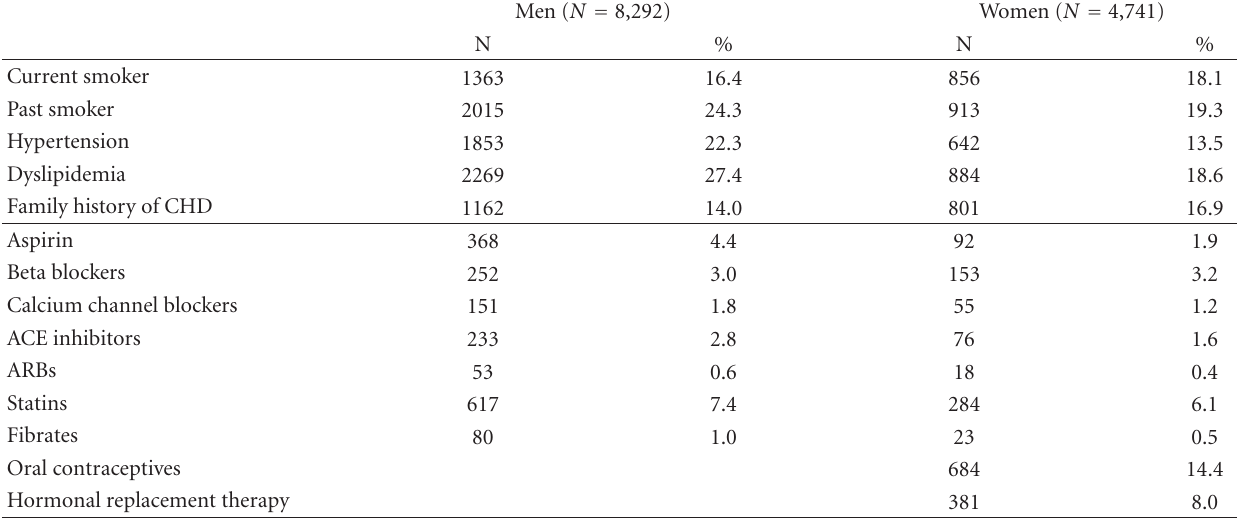
Table 2: Frequency of cardiovascular risk factors and use of prescription medication in men and